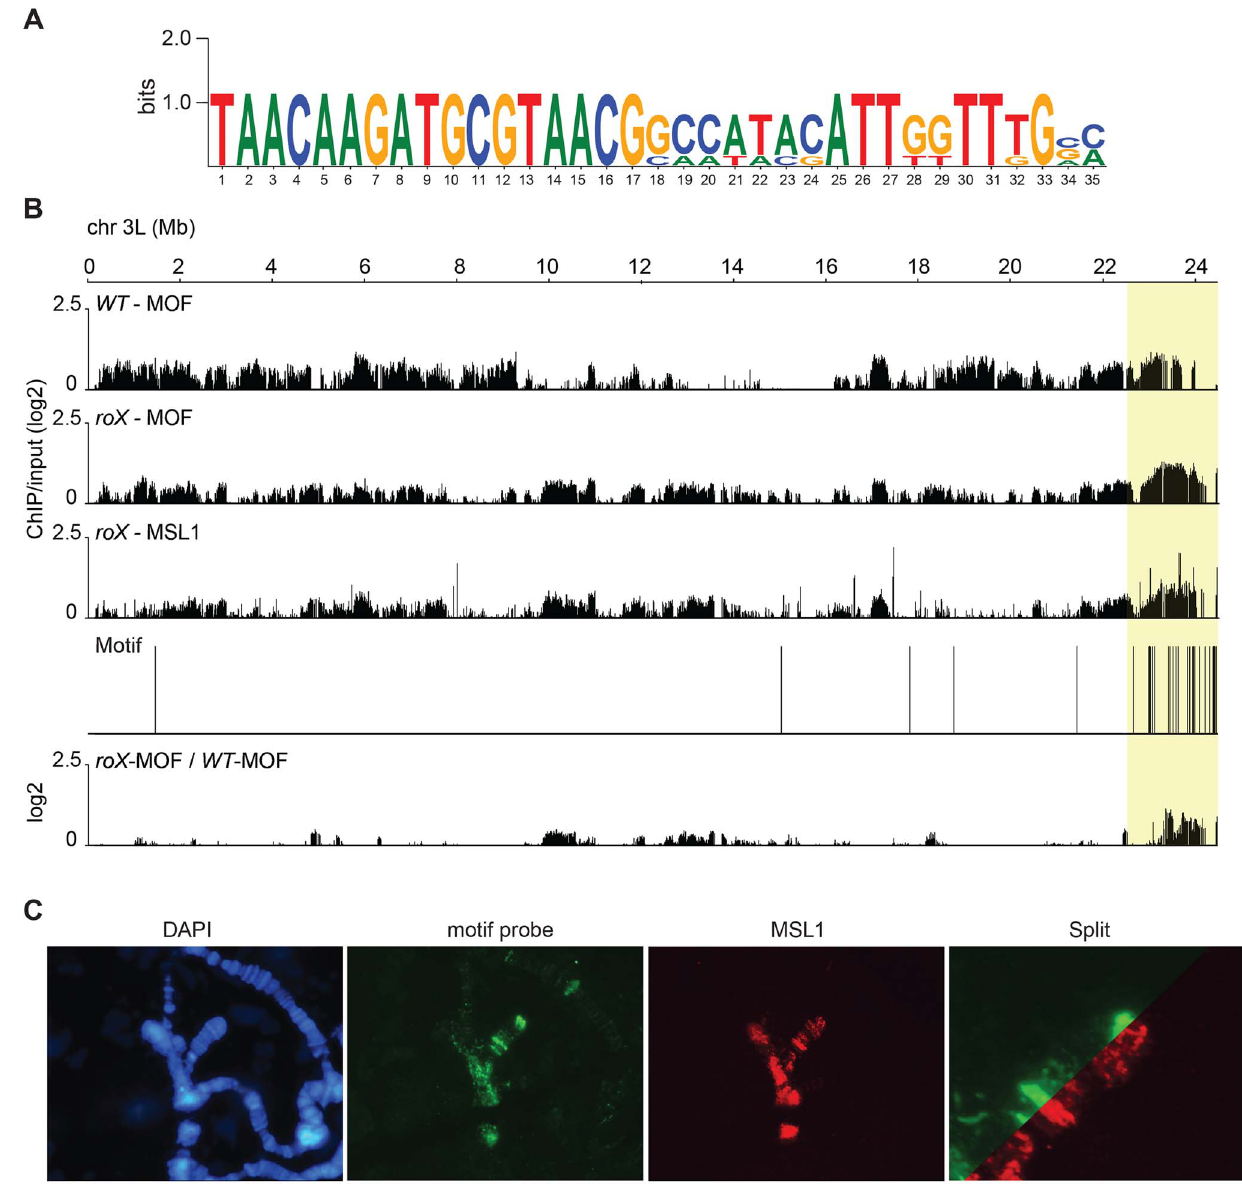
Fig. 4. In roX mutants Hoppel is enriched in MSL-complex. (A) Sequence motif enriched in MSL-bound regions on heterochromatin of roX mutants. (B) MOF and MSL1 ChIP-seq enrichment profiles, with a 2000 bp smoothing, for the representative chromosome arm 3L from wild type and roX mutant males. Numbers along the x-axis denote chromosomal positions along the chromosome in Mb. The y-axis shows the ChIP enrichment over input as log2 ratios. The mapping of the motif along 3L is indicated. Below the motif track the ratio roX -MOF/WT-MOF is plotted. Note that in roX mutants MSL is enriched in the pericentromeric region (indicated by a yellow box). (C) DNA-FISH with a 33 nucleotide long probe against the heterochromatic motif shown in A combined with MSL1 immunostaining, on polytene chromosomes of roX mutant males. Note the overall colocalization between the MSL1 bound regions and the motif hybridisation.